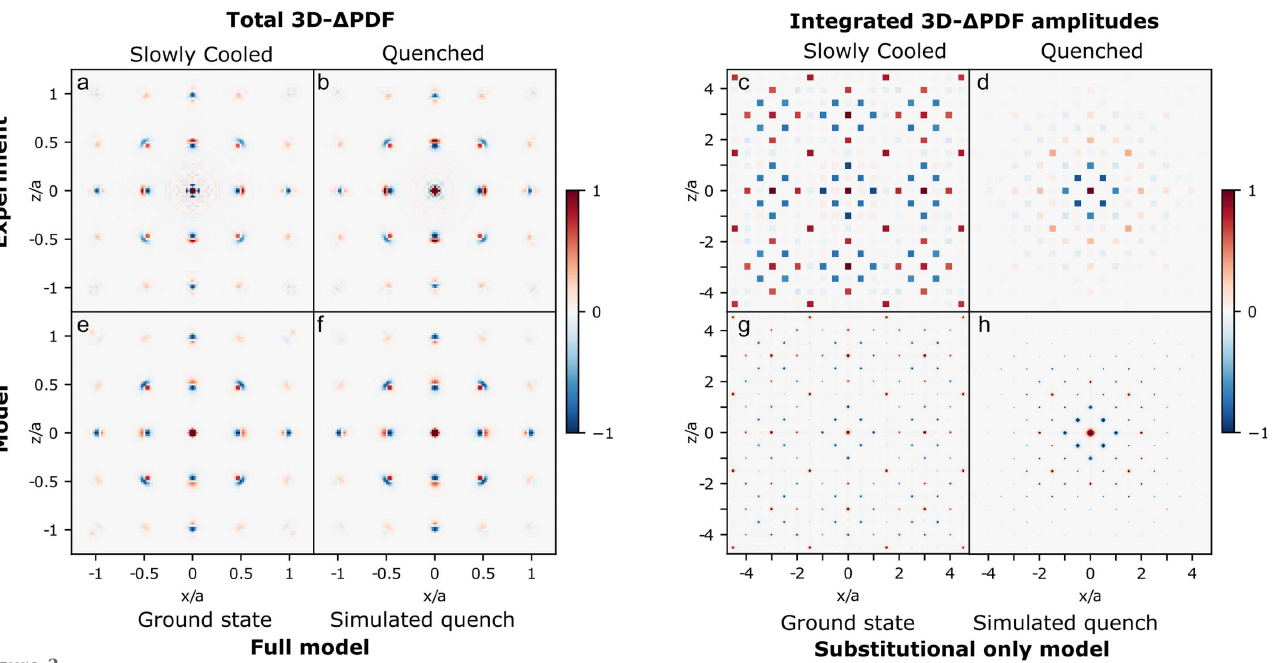
Figure 3 Measured and calculated 3D- (cid:3) PDF. ( a ) and ( b ) Measured 3D- (cid:3) PDF for the ‘SC-0.81’ and ‘Q-0.84 #2’ samples in the 010 plane (same samples as in Fig. 2). ( c ) and ( d ) Integrated peak amplitudes of the 3D- (cid:3) PDF. ( e ) and ( f ) Calculated 3D- (cid:3) PDF using the vacancy repulsion model including Sb and Co relaxation. Both plots have a vacancy concentration of x = 1/6 but ( e ) represents a BD-type ground state and ( f ) a simulated quench with J 2 / J 1 = 0.5. Details of the ground-state structure are given in the supporting information. ( g ) and ( h ) Calculated 3D- (cid:3) PDF using the vacancy repulsion model without Sb and Co